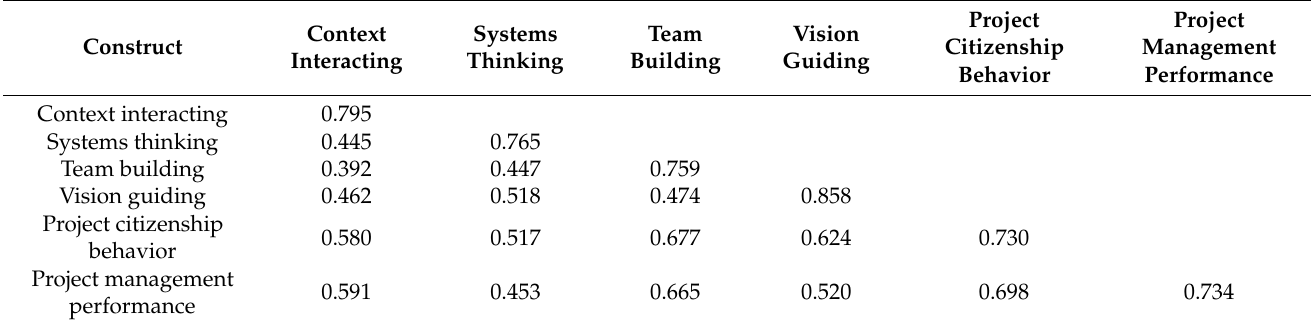
Table 8. Discriminant validity—Fornell–Larcker